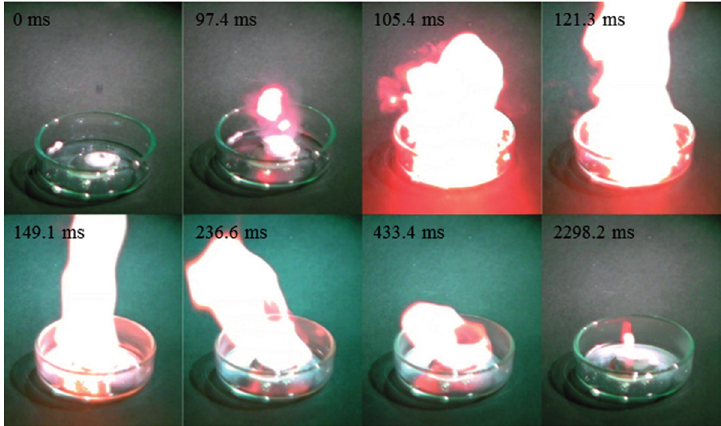
Figure 4. ID time photographs of the mixture hypergolic chemicals with [TMH] + [N 3 ] − and HOCH 2 NHNH 2 using H 2 O 2 .